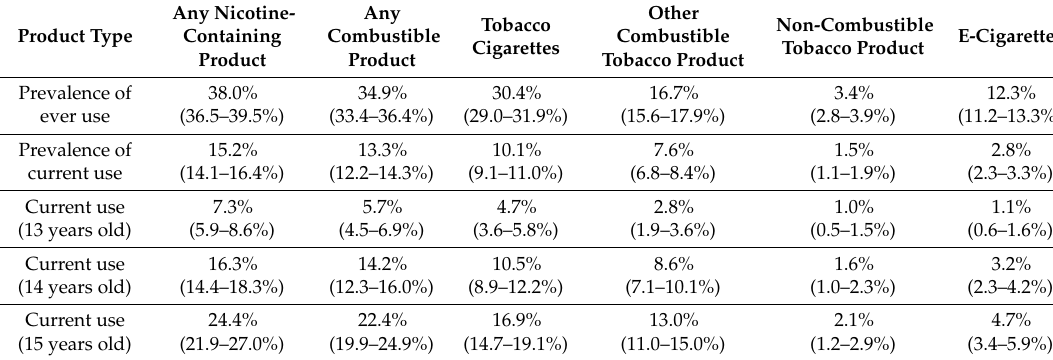
Table 2. Prevalence of nicotine product use by type in 2013.